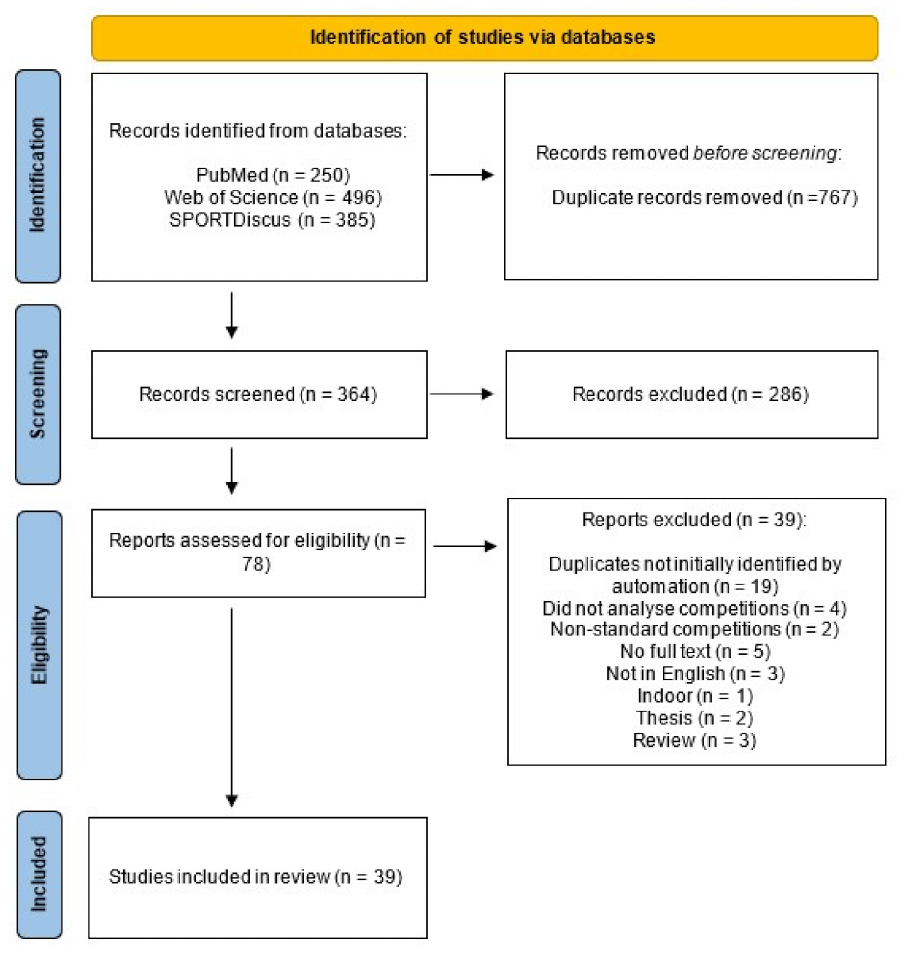
Figure 2. PRISMA